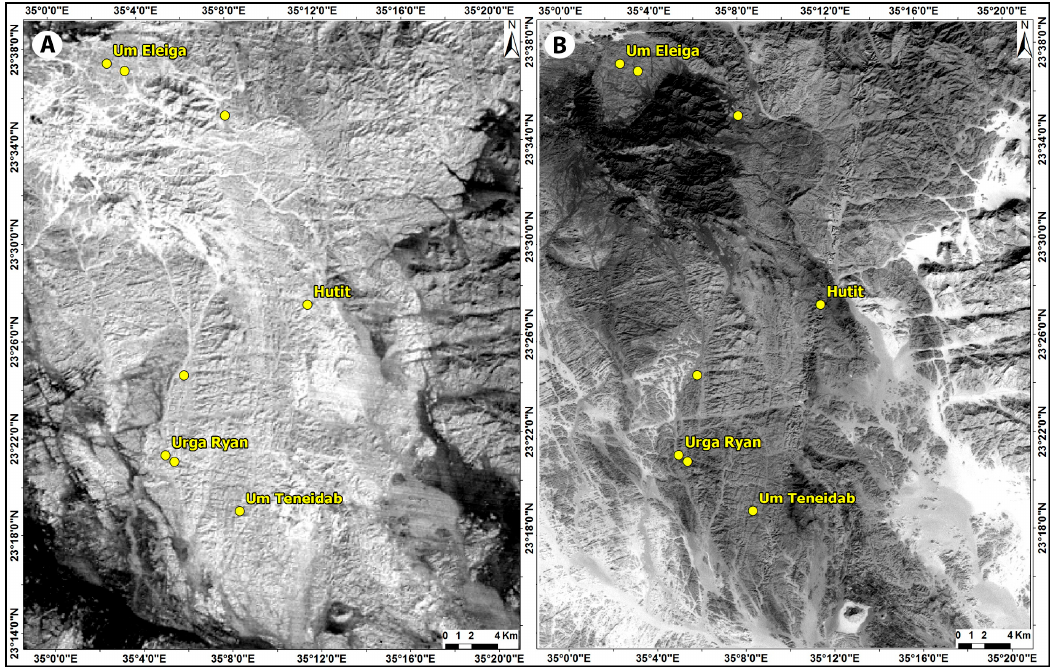
Figure 6. Mineralogical indices images based on the ASTER–SWIR data of the study area. ( A ) Grayscale image of the carbonate index (CI) of Ninomiya [65]; ( B ) grayscale image of the Fe-Mg-OH-MI after Pour et al. [21].